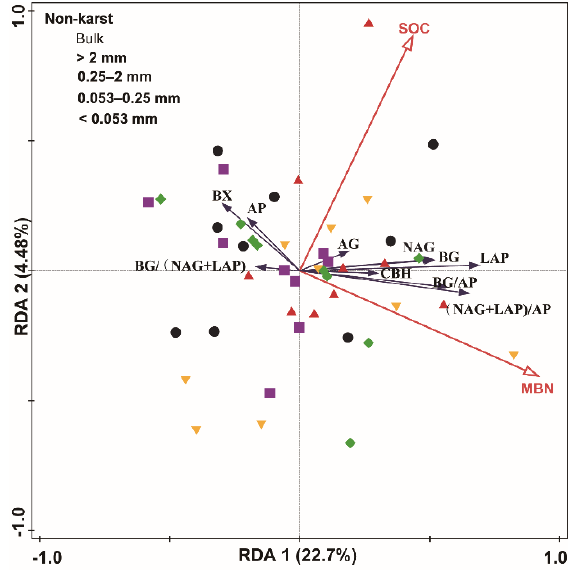
Figure 7. Redundancy analysis (RDA) plot showing the relationship between the environmental factors and the enzyme activity and enzyme stoichiometric ratio of karst and non-karst forests. Percentages indicate the proportions of variance explained by each axis. Red lines represent the envi- ronmental variables, and blank lines represent the enzyme activity and enzyme stoichiometric ratio.